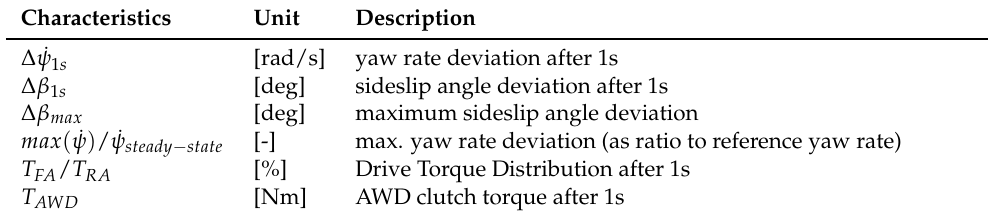
Table 3. Assessment criteria for the PON